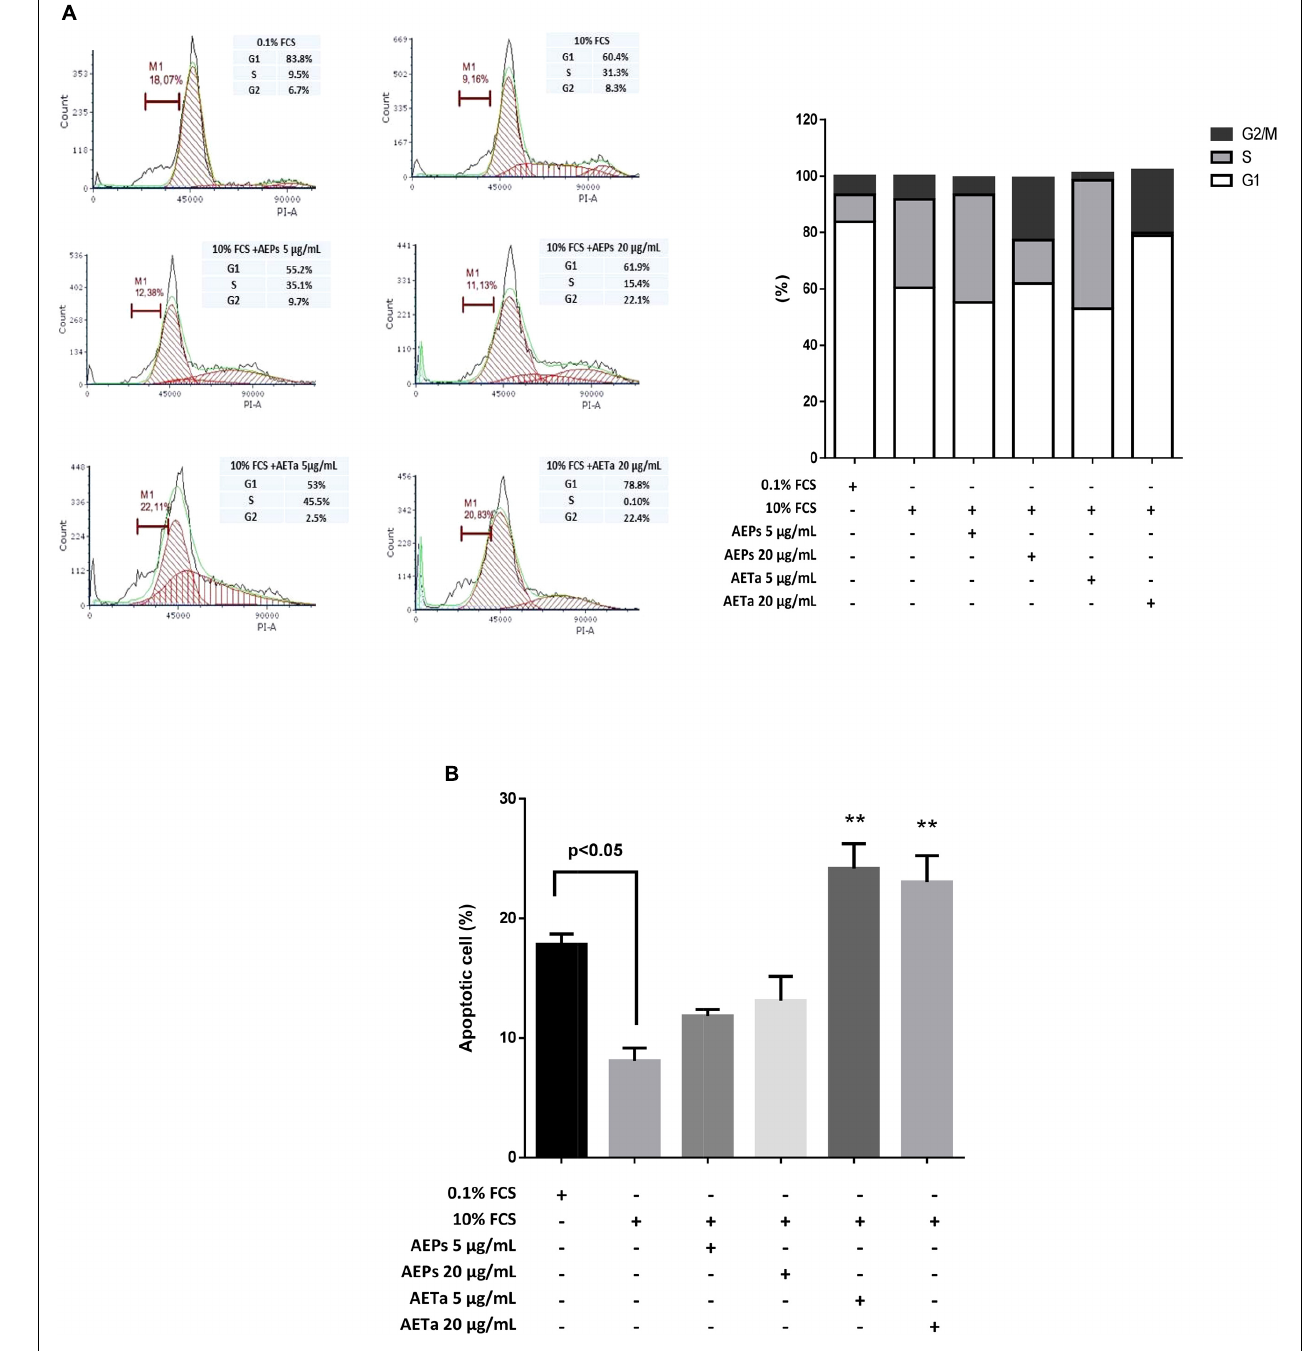
FIGURE 2 | Effect of Prosopis strombulifera and Tessaria absinthioides on cell cycle progression. (A) DNA content staining with propidium iodide was analyzed by flow cytometry after 24-h incubation of treatment. Percentage of cell population in G1, S, and G2 phases of the cell cycle is shown. VSMC culture in 10% FCS and treated with AEPs and AETa (20 µ g/ml) resulted in accumulation of cells at the G2 phase. (B) Apoptotic cell percentage was evaluated by sub-G0 population. AETa (5 and 20 µ g/ml) treatments resulted in VSMC apoptosis induction after 24-h incubation. Data are shown as the mean ± SEM of two independent experiments. ** p ≤ 0.01 compared with 10% FCS group. VSMC, vascular smooth muscle cell; FCS, fetal calf serum; AEPs, aqueous extract of P. strombulifera ; AETa, aqueous extract of T. absinthioides .